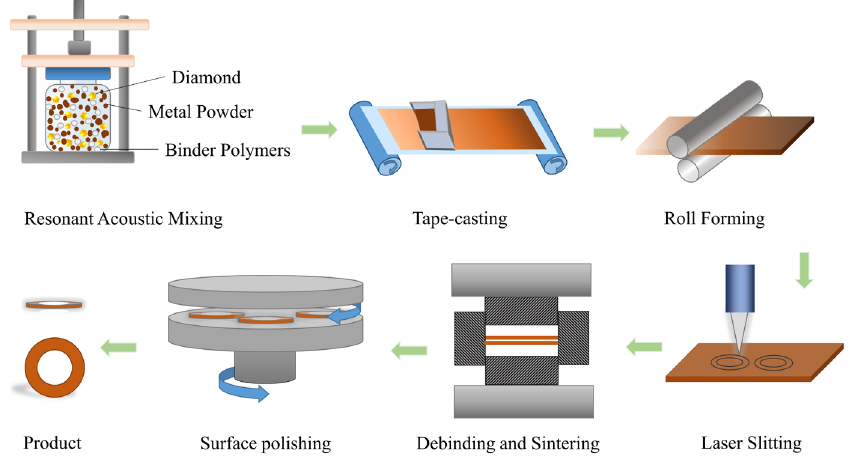
Figure 1. Fabrication procedure of the diamond blade via rolling-slitting.